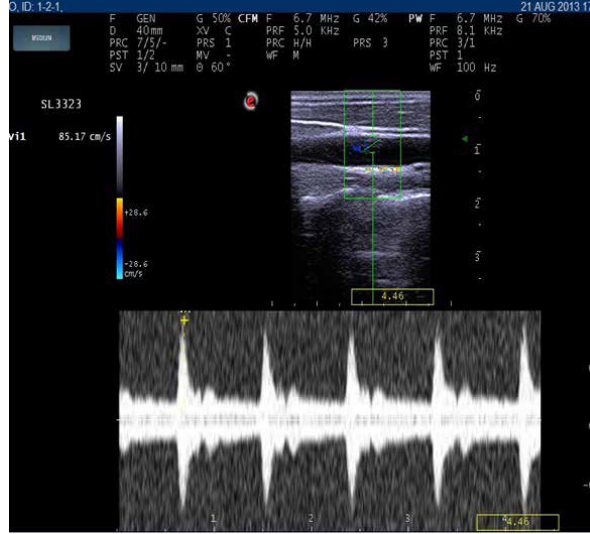
Figure 3: Measurement of change in the blood flow velocity